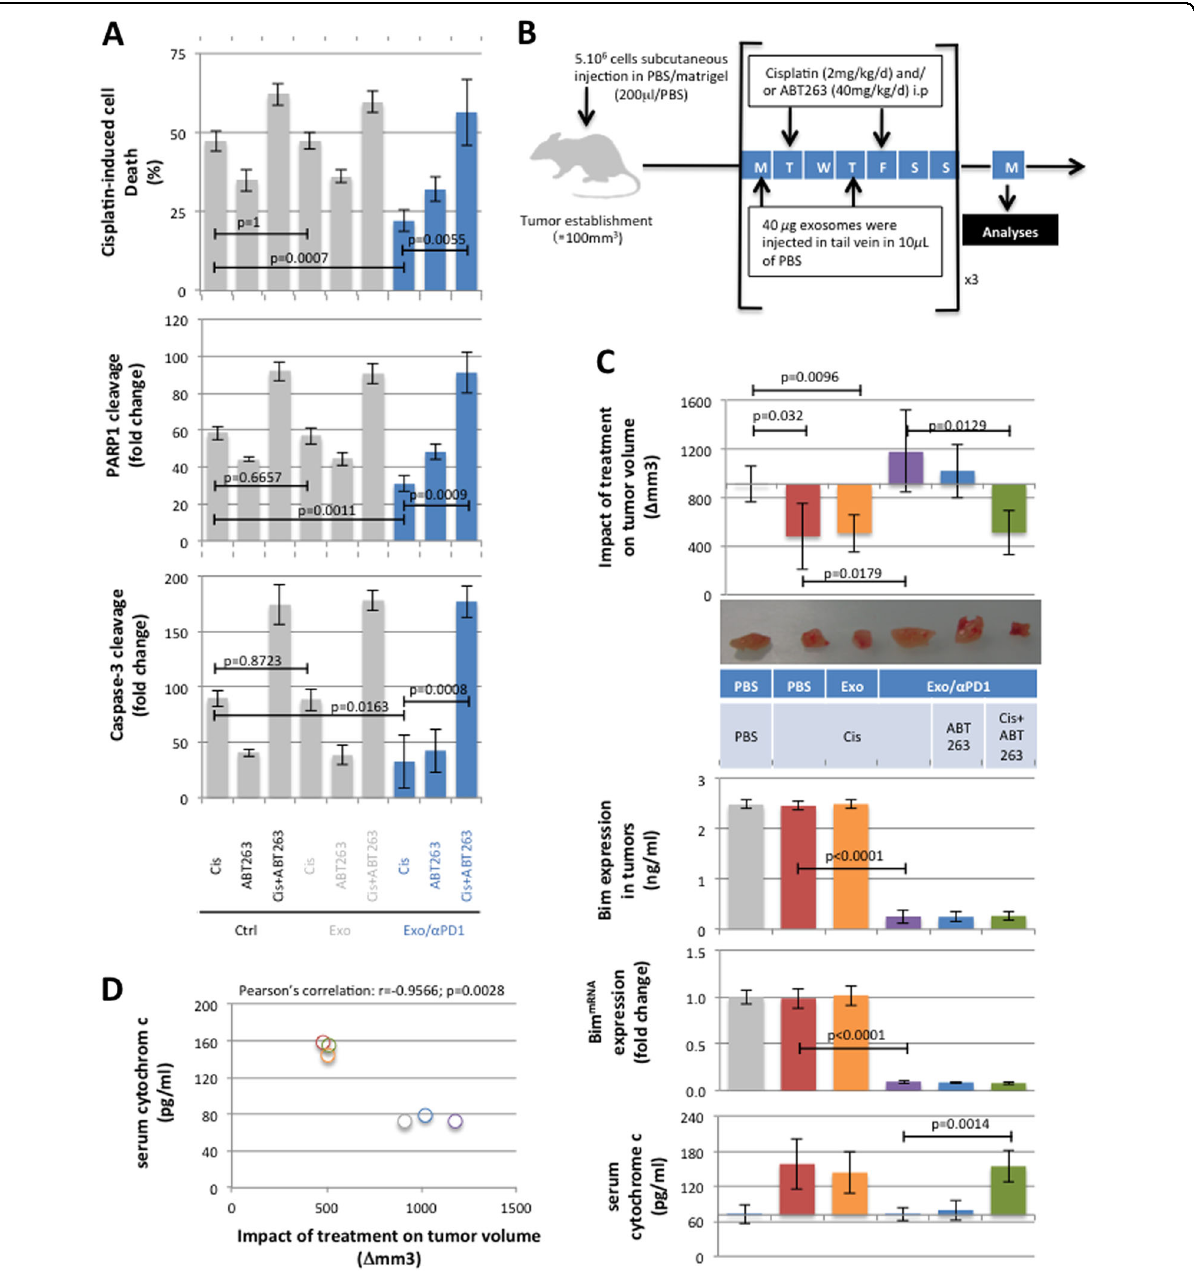
Fig. 5 ABT263 abrogates anti-PD1/exomiR-4315-induced resistance to chemotherapy in an in vivo model of lung cancer. A Cisplatin- induced cell death measure and PARP and Caspase-3 cleavage studies were applied to show that the phenotype of cisplatin resistance induced by exosomes derived from T cells exposed to α PD1 (Exo/ α PD1) was abrogated by the use of ABT263.A Cell. B Schematic representation of our in vivo experimentations. C Graph represents the impact of treatment on tumor volume, Bim expression at mRNA (RT-qPCR experiments) and protein (ELIZA, Bim ELIZA Kit MyBioSOURCE#MBS9500064, USA) levels and on the level of serum cytochrome c (Cytochrom C ELIZA kit, Biovision#E4286-100, France). Each treatment included four mice. D Correlation between the impact of treatment on tumor volume and the level of serum cytochrome c in